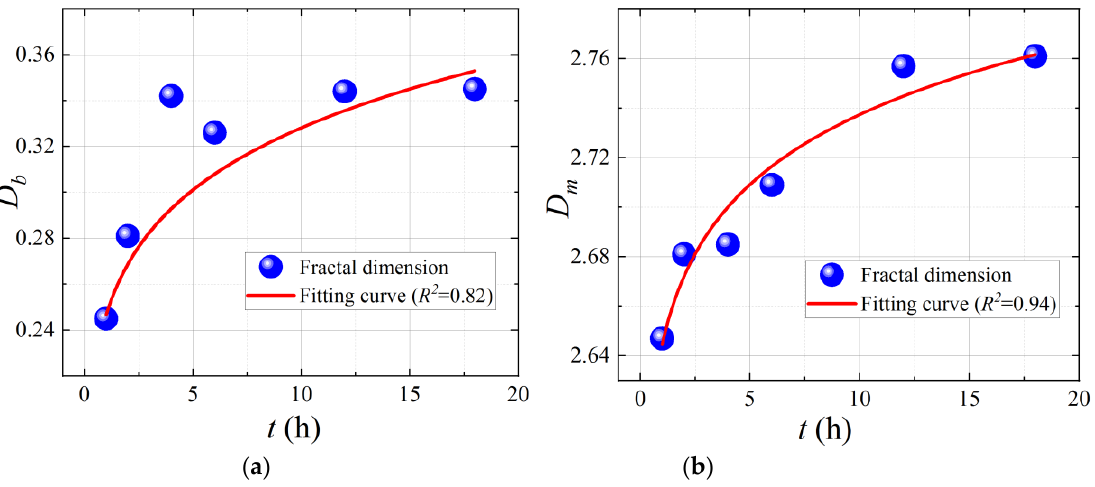
Figure 10. The lg S v-lg R curves under various freezing temperatures: ( a – c ) represent −3 °C , −8 °C and −20 °C , respectively.